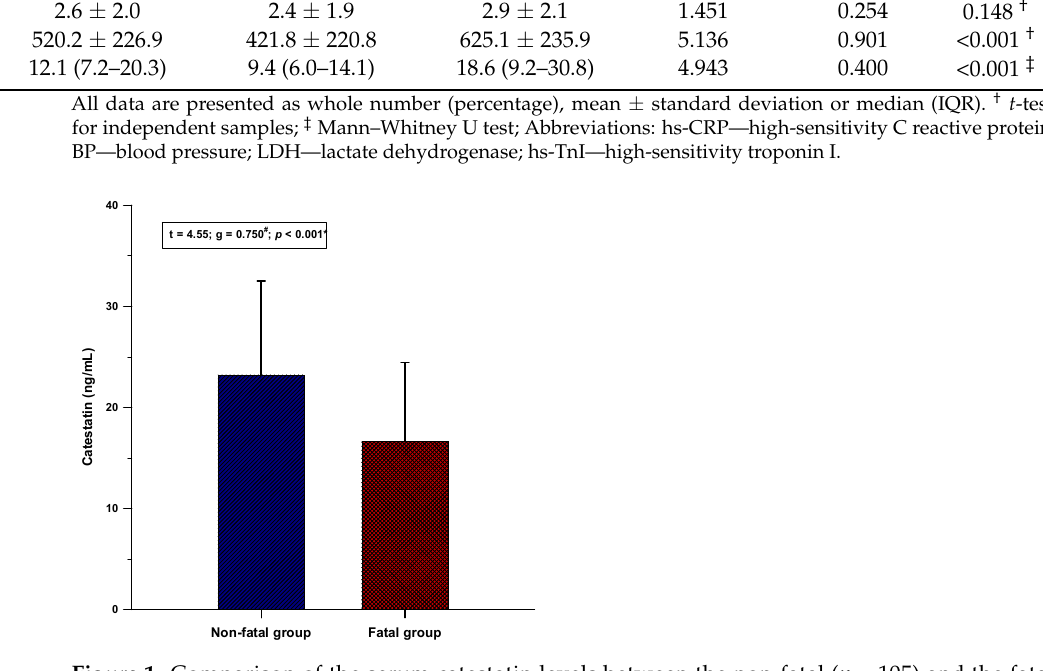
Figure 1. Comparison of the serum catestatin levels between the non-fatal ( n = 105) and the fatal ( n = 47) group. Data are presented as mean ± standard deviation * Student’s t -test, # Hedges’ g. Furthermore, serum vitamin D levels were significantly lower in the fatal group (30.4